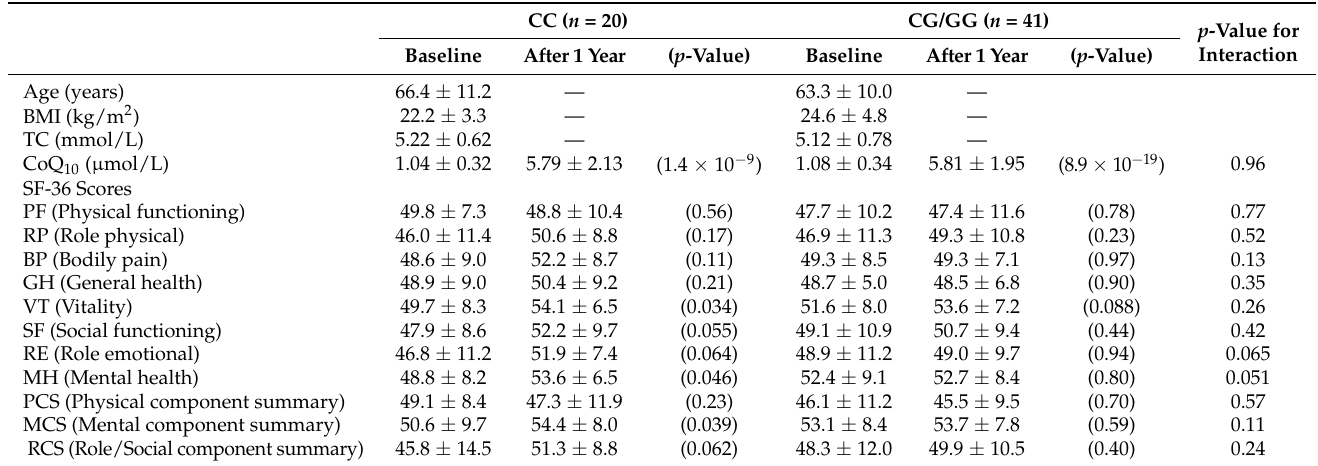
Table 3. Changes in the measurements of rs2072183 (C > G) in NPC1L1 during the reduced CoQ 10 supplementation in women.